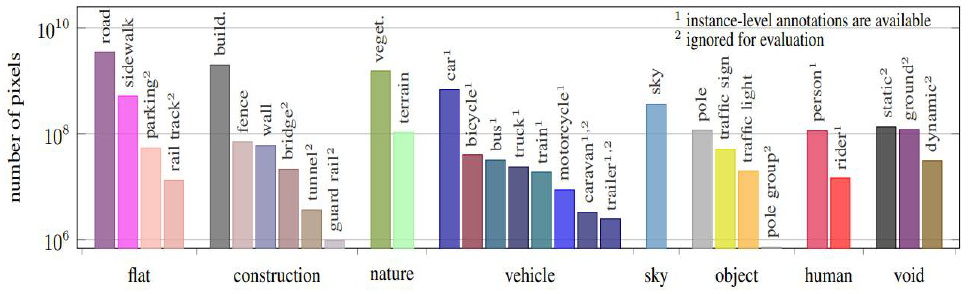
Table 2. Specifications of classical models.